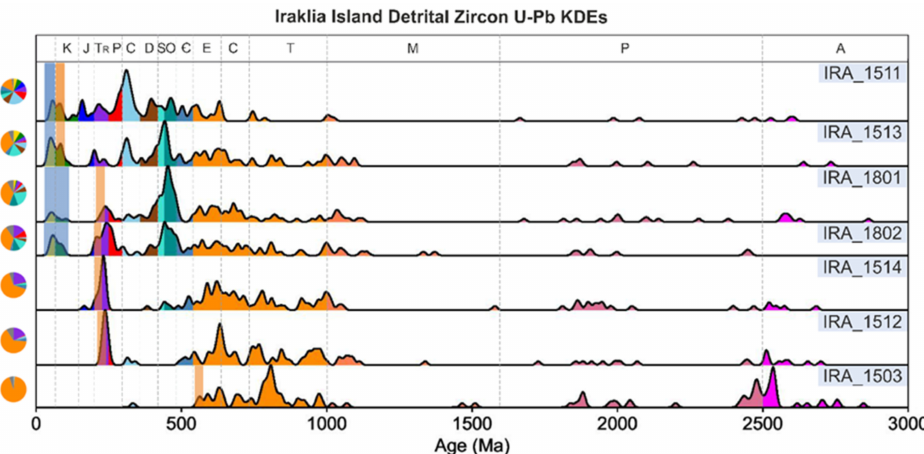
Figure 8. Detrital zircon U-Pb KDEs results. The diagrams show the compiled data from 3000-0 Ma for each sample. MDAs and metamorphic zircon rim ages are depicted in light-orange and blue, respectively. The pie diagrams show the proportions of core-age